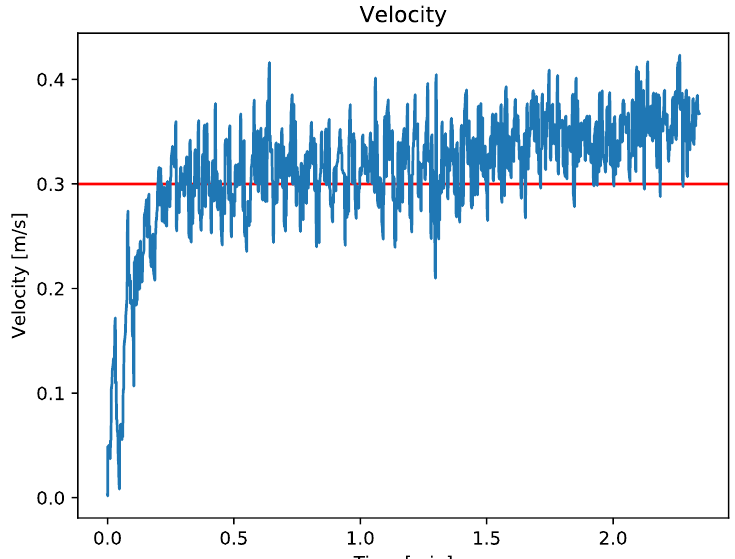
Figure 12. The red line represents the target speed set at 0.3 m/s. The blue line depicts the actual speed of the vehicle during the test. The sample mean between minutes 0.3 and 2.3 is 0.313 and the standard deviation is 0.058.